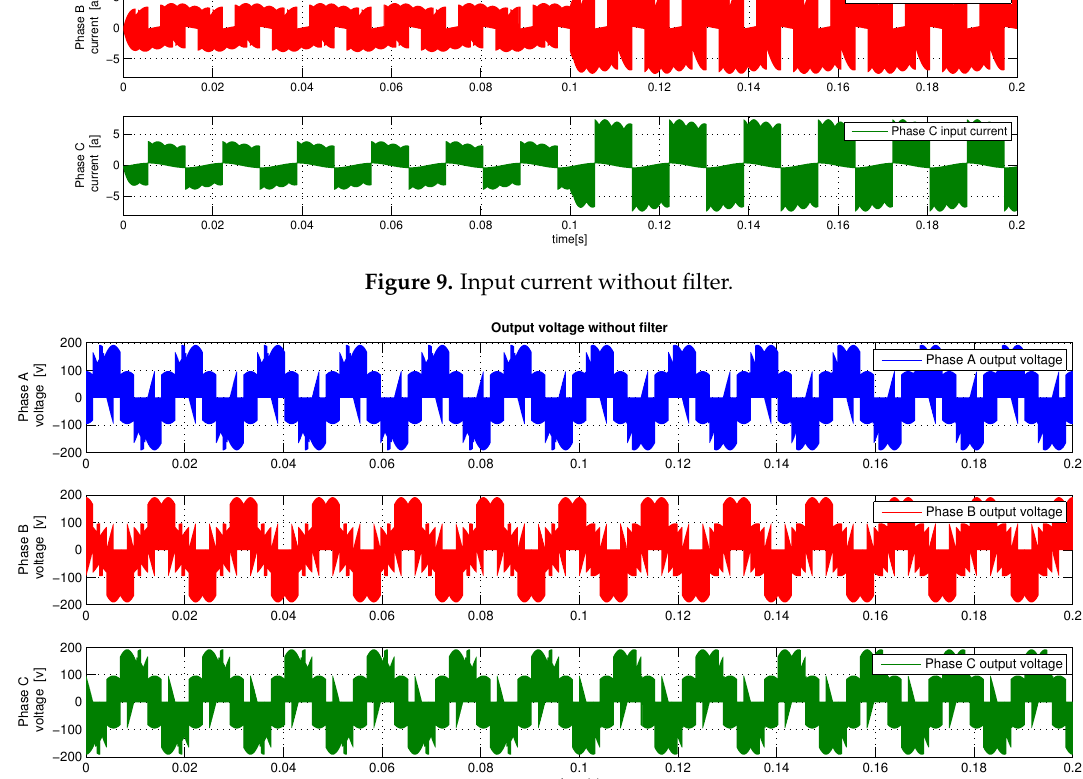
Figure 10. Output voltage without